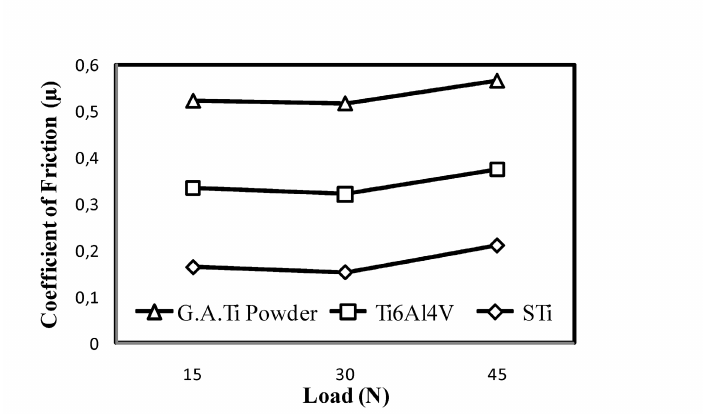
Figure 6. Friction coefficients of the sponge titanium, gas atomised titanium and Ti6Al4V